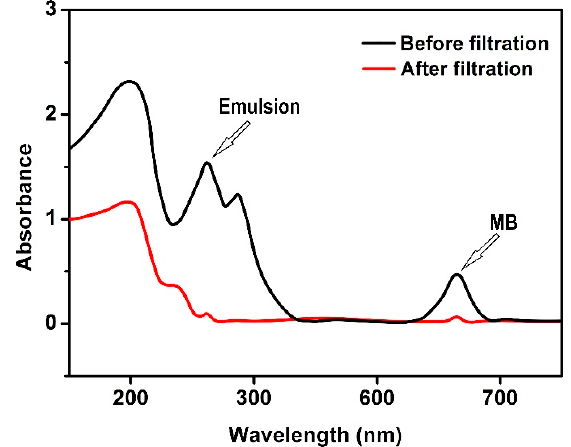
Figure 12. The UV-Vis spectrum of pollutant solution before and after filtration.